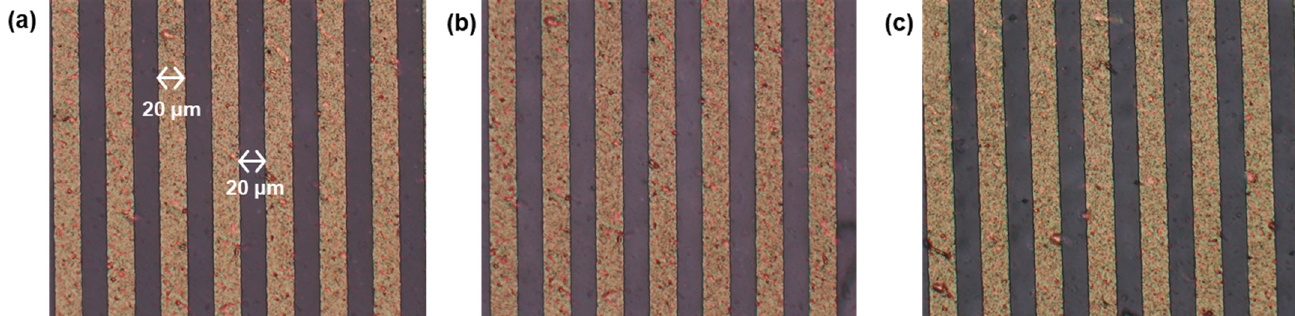
Figure 7. Microscopic images of the metal patterns on the 8 μ m thick PET film ( a ) before and ( b ) after detachment. ( c ) A microscopic image of the metal patterns of the flexible electrode after 10,000 folding test cycles. The mechanical durability of the flexible electrode was evaluated through a U-shape folding test [22]. Both the ends of the electrode were attached on a guide film adhered to two plates using a Scotch tape (Figure 2a). During the folding cycles, the two plates were repeatedly moved towards each other to fold the electrode into a U-shape and moved away from each other to unfold the electrode (Figure 2b). The folding radius and folding rate for the test were 2 mm and 25 cycles/min, respectively. The line resistance of the flex- ible electrode was measured as 9.03 (±0.37) × 10 2 Ω after 10,000 folding test cycles, imply- ing that the electrode was mechanically durable. No cracking or delamination of the Mo/Al/Mo layers was observed by microscopy (Figure 7c) after numerous folding cycles with a narrow folding radius. This mechanical durability was ascribed to the pliability of the electrode with a sub-tenth micron thickness. 4. Conclusions In this study, amide-tethered methacrylate (Me-am 2) was synthesized and used to fabricate an h-PSA. The amide hydrogen bonding not only endowed the h-PSA with high